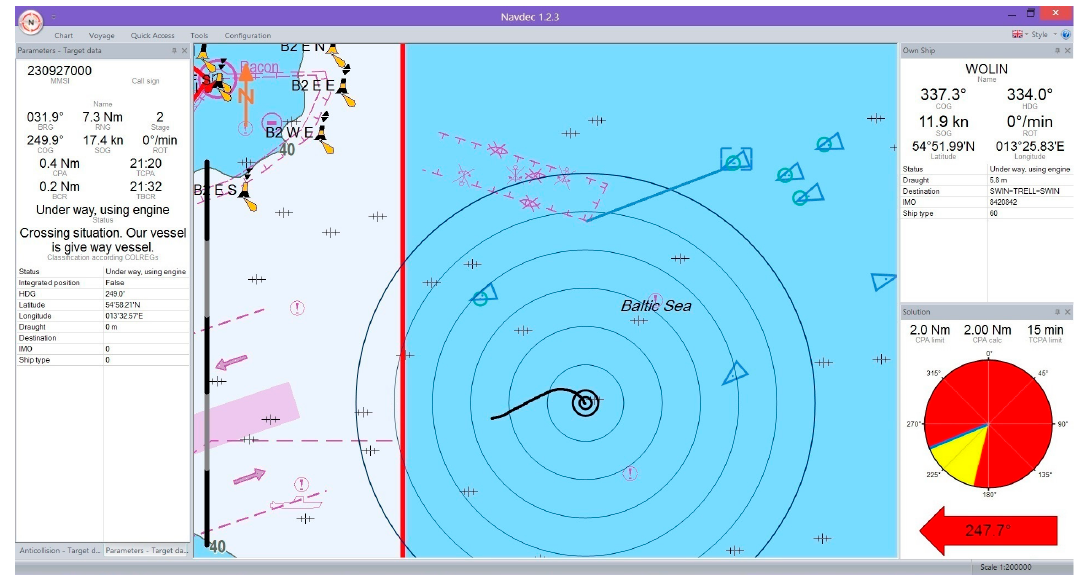
Figure 5. The ship trajectory prediction in the NAVDEC system—example two.